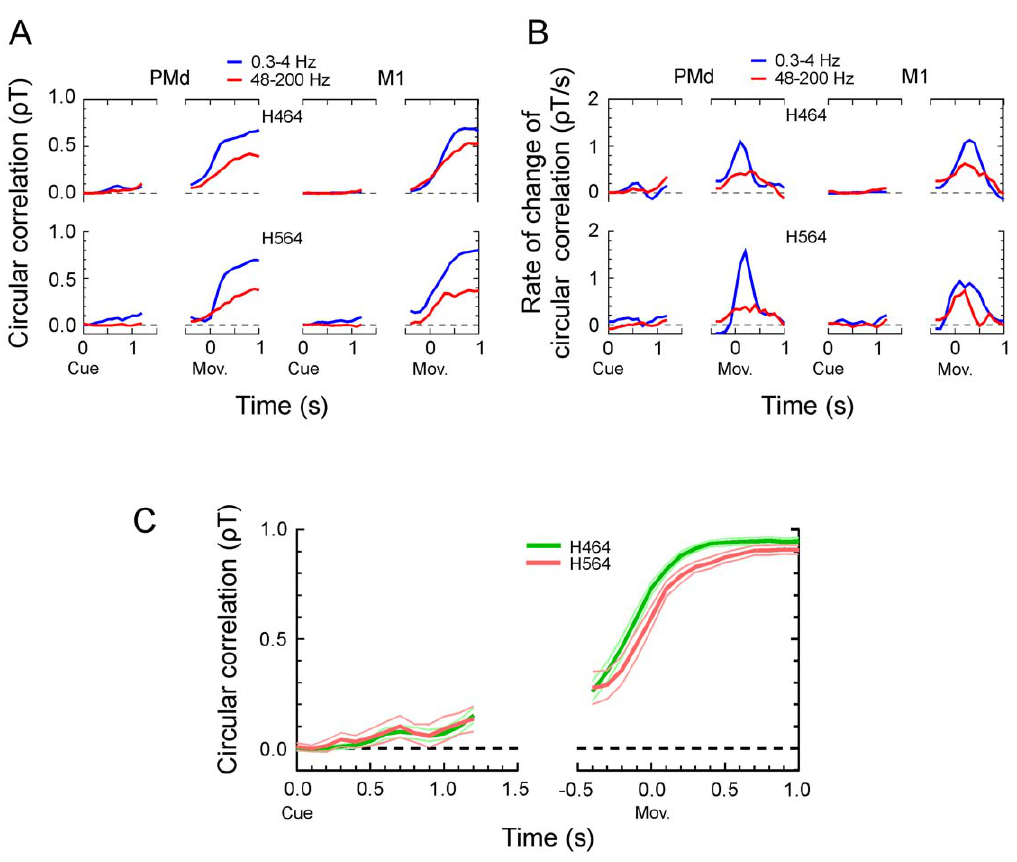
Figure 5. Temporal evolution of decoding accuracy. (A) Time-varying circular correlation between predicted and actual target direction for the two most informative sub-bands, and for each brain area and subject. The results at each time point were obtained using data from a time-window (500 ms for the cue and 1000 ms for movement onset aligned data, respectively) that preceded that time point. (B) Time-varying rate of change of circular correlation between predicted and actual target direction. Same conventions as in A. (C) Time-varying circular correlation between predicted and actual target direction using combined features obtained with the delta and upper gamma sub-bands from PMd and M1 for each subject. The thinner lines indicate the 95% confidence interval of the mean computed on the basis of the corrected t -test [25; 26].